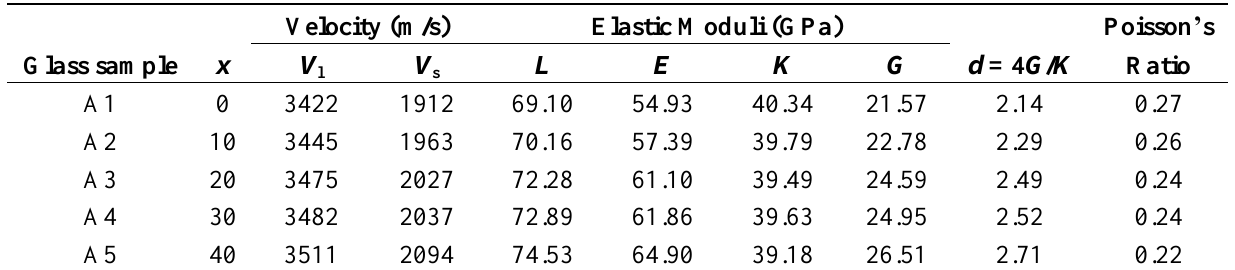
Table 2. The room temperature ultrasonic wave velocities and elastic moduli of the ternary lead-bismuth germanate glasses together with fractal dimensionality and Poisson’s ratio.